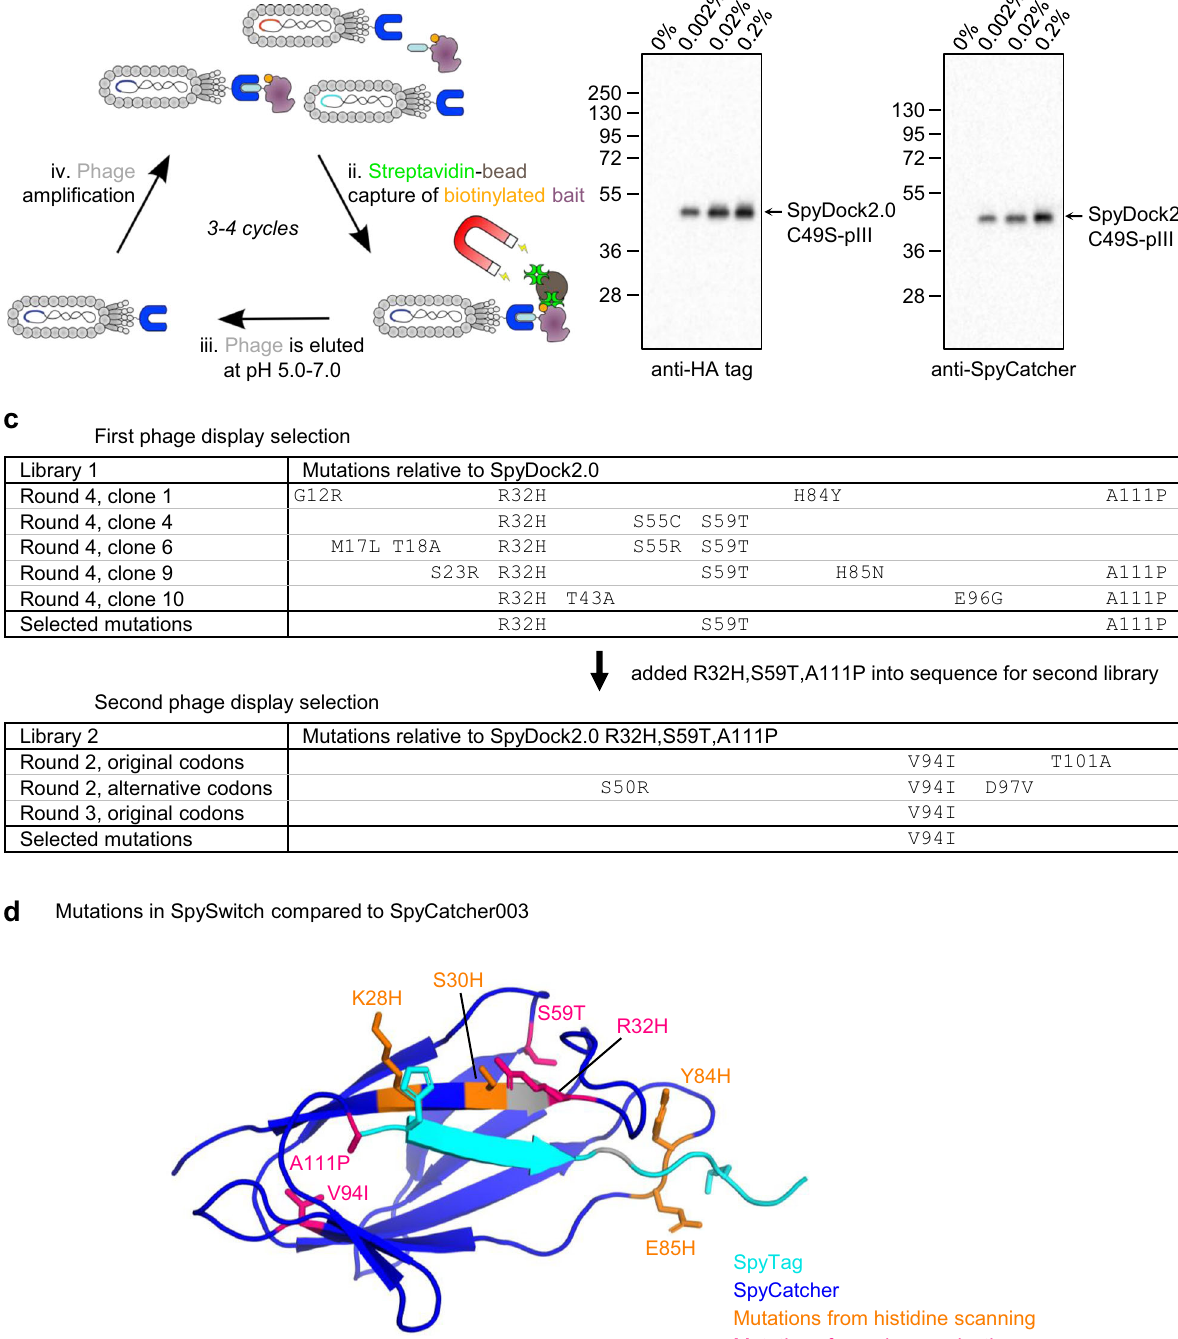
Fig. 2 Library selection of SpySwitch. a SpySwitch selection strategy. Biotinylated AviTag-SpyTag003-MBP was incubated with a library of M13 phage displaying SpyDock2.0 variants, before pull-down and pH elution. b Validation of phage display. Reducing Western blot of phage, induced with increasing arabinose, displaying SpyDock2.0 C49S-pIII, bearing an N-terminal HA tag. The membrane was blotted with anti-HA tag (left gel) or anti-SpyCatcher (right gel). Molecular weight markers represent kDa. c Amino acid sequences of phage display libraries. Library 1 is based on SpyDock2.0 C49S. Library 2 is based on successful mutations from library 1. d Mutations in SpySwitch. His scanning mutations in orange and phage display mutations in magenta are marked on the structure with side-chains in stick format, based on PDB ID: 2X5P for SpyCatcher (in dark blue) and PDB ID: 4MLI for SpyTag (in cyan). H112 and K120 side-chains on SpyTag (K123 is not resolved in PDB ID: 4MLI) are marked as potential sites of electrostatic repulsion. Source data are provided as a Source data fi